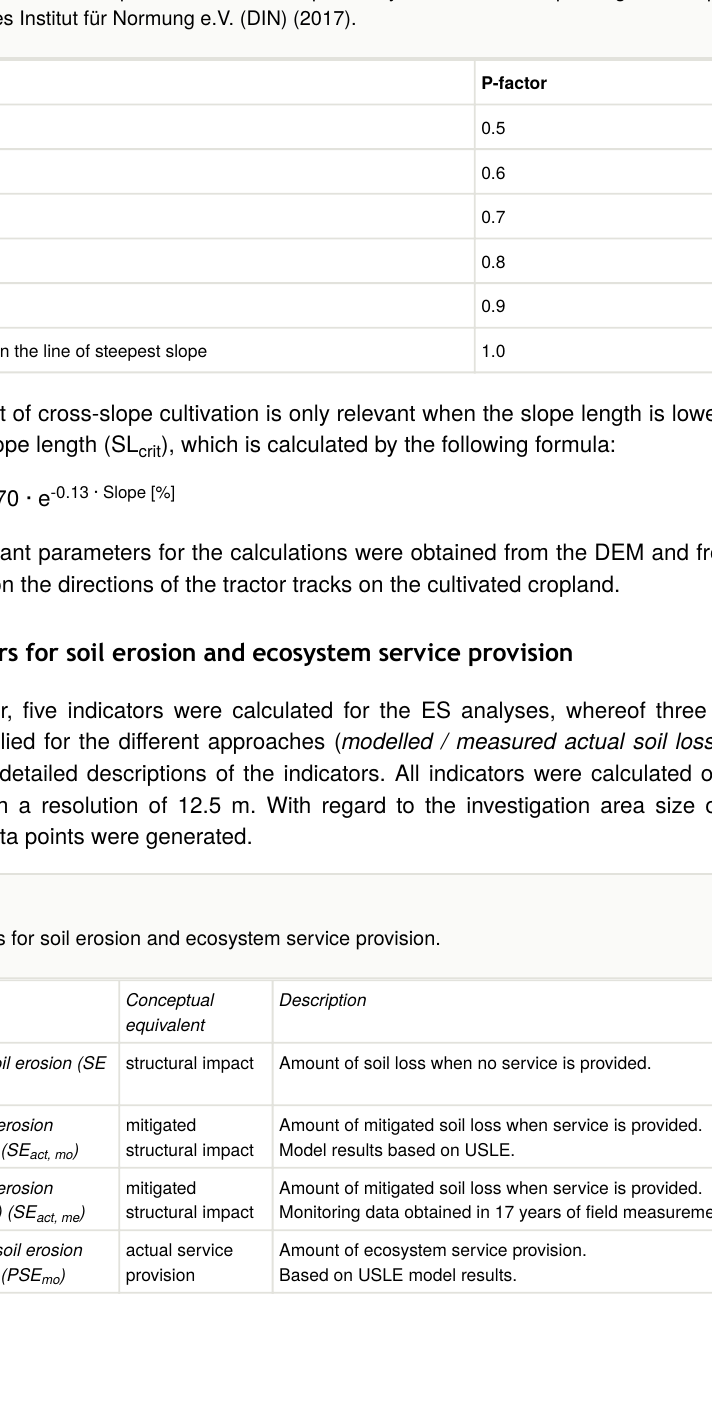
P-factor for cross-slope cultivation in dependency of di ff erent slope angles. Adapted from